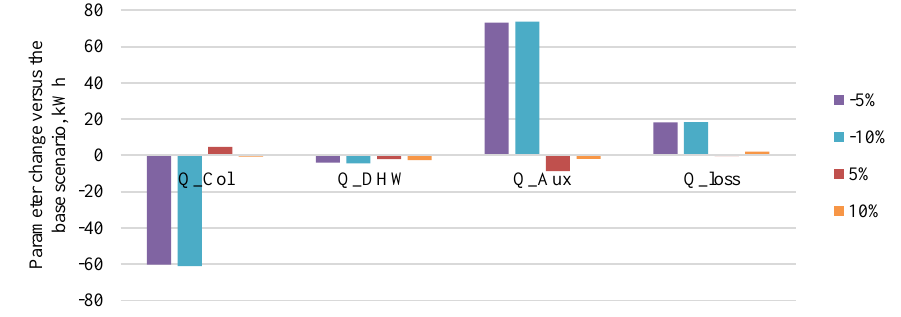
Fig. 6. Melting point change impact on